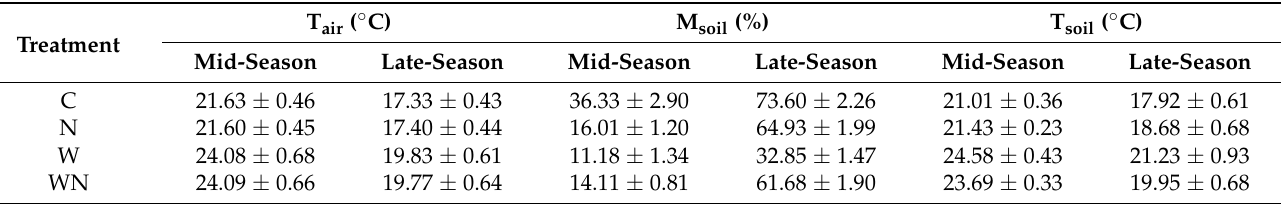
Table 3. Air temperature (T air ) , soil moisture (M soil ), and soil temperature (T soil ) in Control (C),